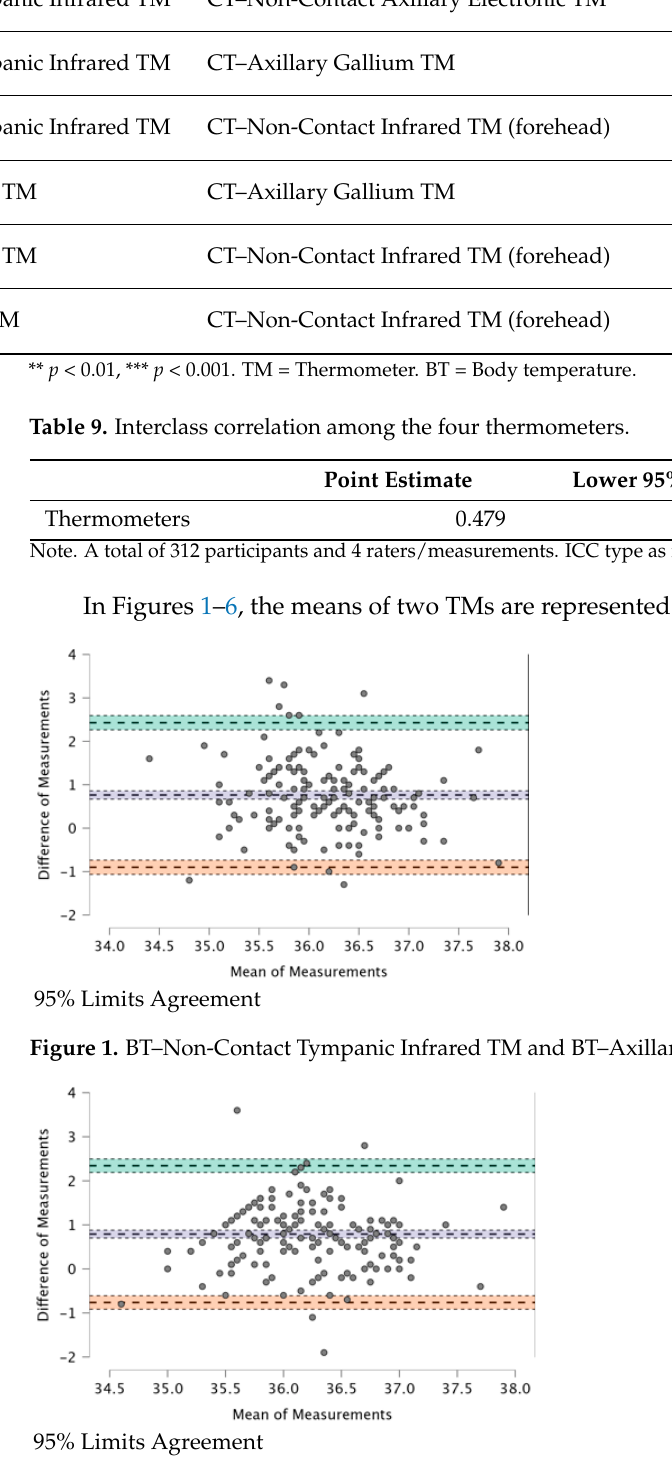
Figure 2. BT–Non-Contact Tympanic Infrared TM and BT–Axillar Gallium